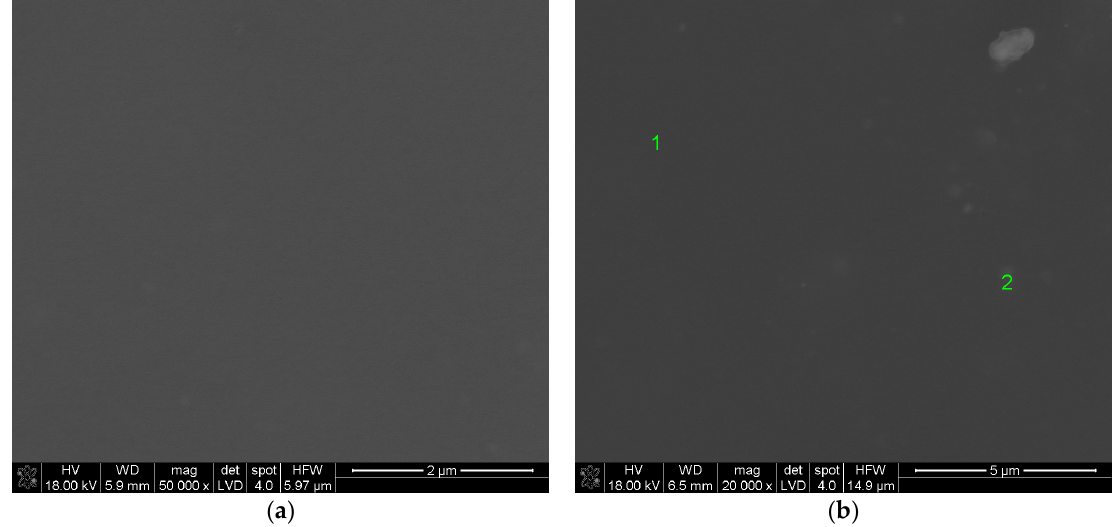
Figure 8. Surface of the layer deposited at 500 °C. Molar percentage of Sm(tmhd) 3 : about 14%. Synthesis time: 20 min. Other synthesis parameters: same as in the case of the sample from Figure 7. Magnification: about 50,000× ( a ) and 20,000× ( b ).